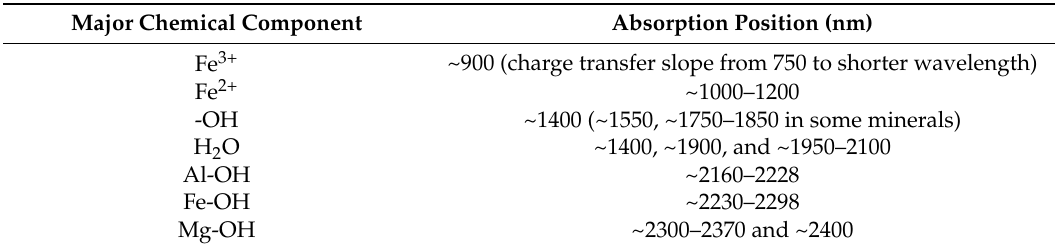
Table 3. The common absorption features of major components in VNIR-SWIR regions [26,27,62,72,73].